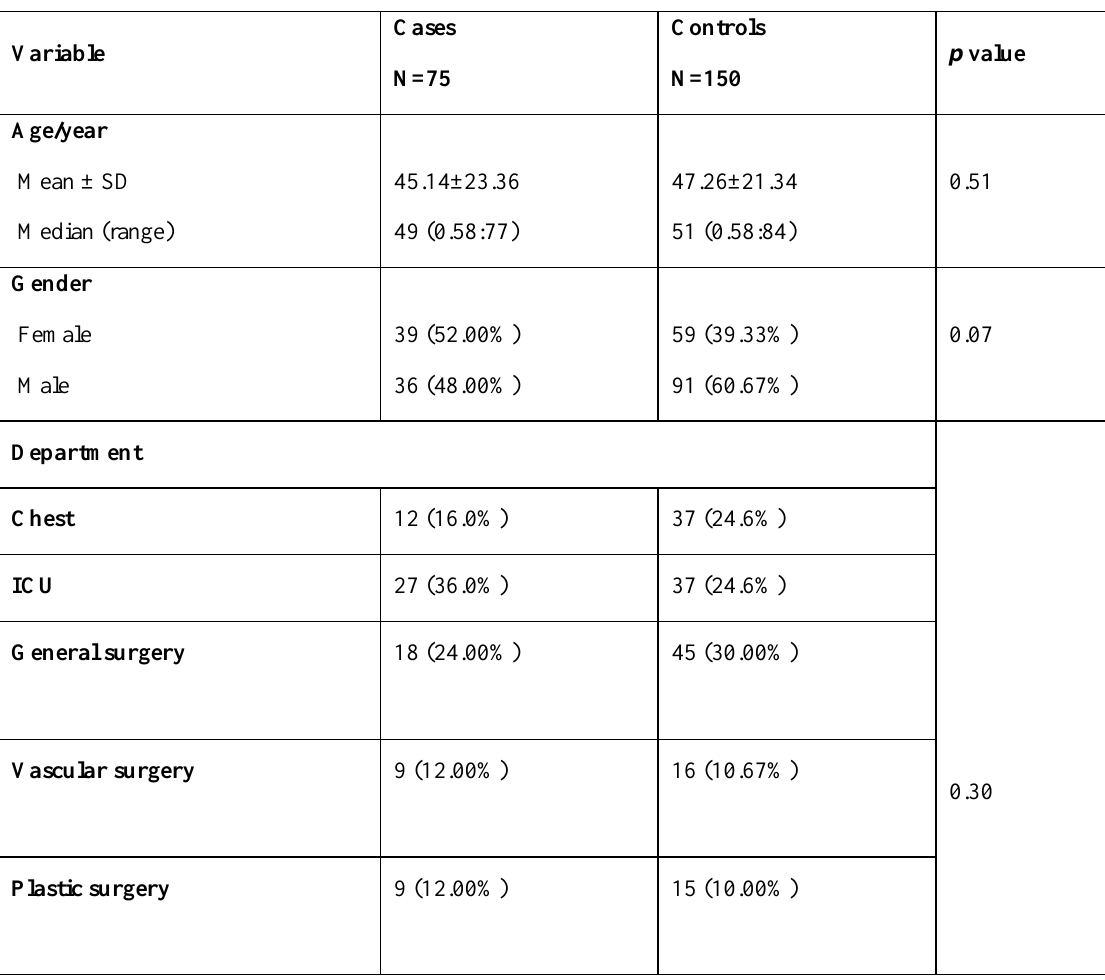
Table 1. Demographic data and department of admission of the study